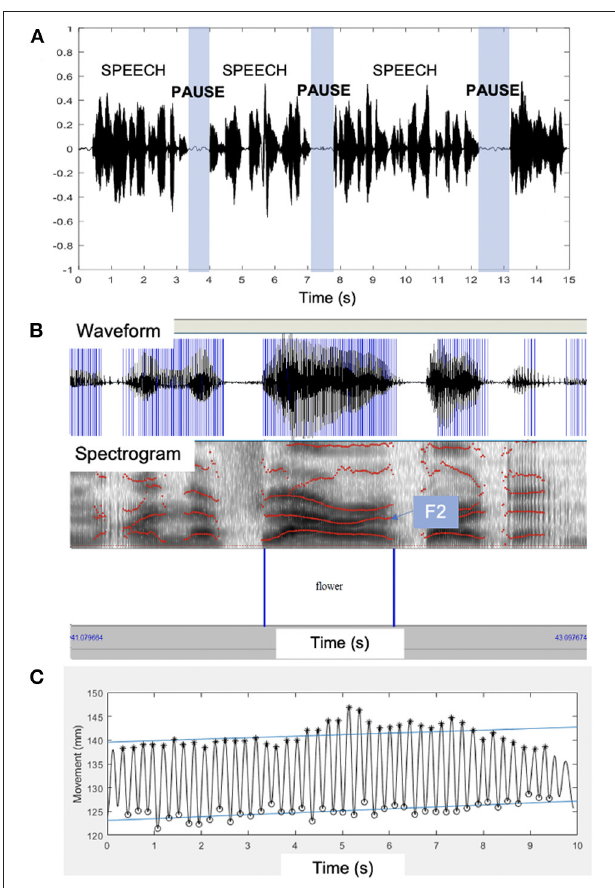
FIGURE 1 | Examples of the quantitative speech measures used in this paper. (A) A rendering of speech pause analysis (SPA) 18 of the acoustic waveform with speech and pause segments marked over time. (B) The acoustic waveform and spectrogram with the second formant (F2) marked on the spectrogram from which F2 range was extracted. (C) Kinematic signal derived from lip movements during the rapid syllable repetition task. F2, second formant; s,